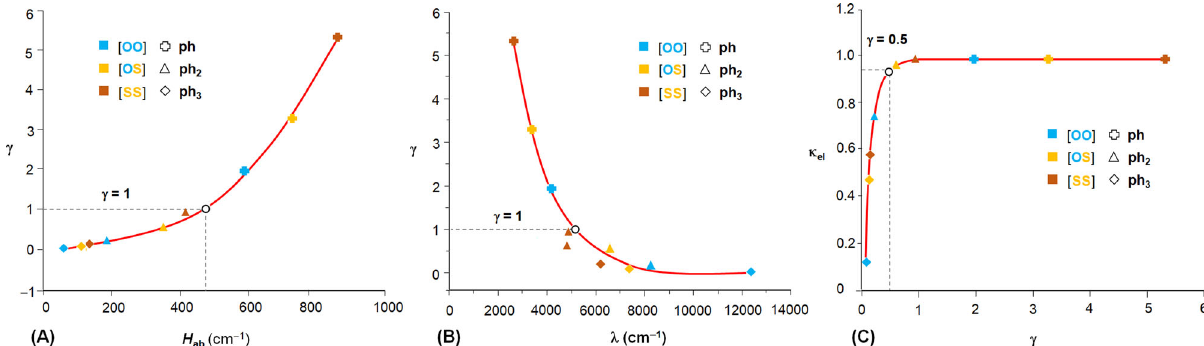
Fig. 6 Impacts of the electronic and nuclear factors on the Landau – Zener parameters γ and κ el in systems [EE ′ – (ph) n – EE ′ ] + (E,E ′ = O or S, n = 1 – 3). A Plot of γ vs. H ab , showing the variation of adiabatic parameter ( γ ) as a function of the transfer integral ( H ab ). B Plot of γ vs. λ , showing the variation of adiabatic parameter ( γ ) as a function of reorganization energy ( λ ). C Plot of κ el vs. γ , predicting the dependence of transmission coef fi cient ( κ el ) on adiabatic parameter ( γ ). Color codes for [ EE ′ – (ph) n – EE ′ ] + : blue for [ OO – (ph) n – OO ] + , yellow for [ OS – (ph) n – OS ] + , and brown for [ SS – (ph) n – SS ] + . The ph, ph 2 , and ph 3 bridges are represented by cross, triangle, and square,